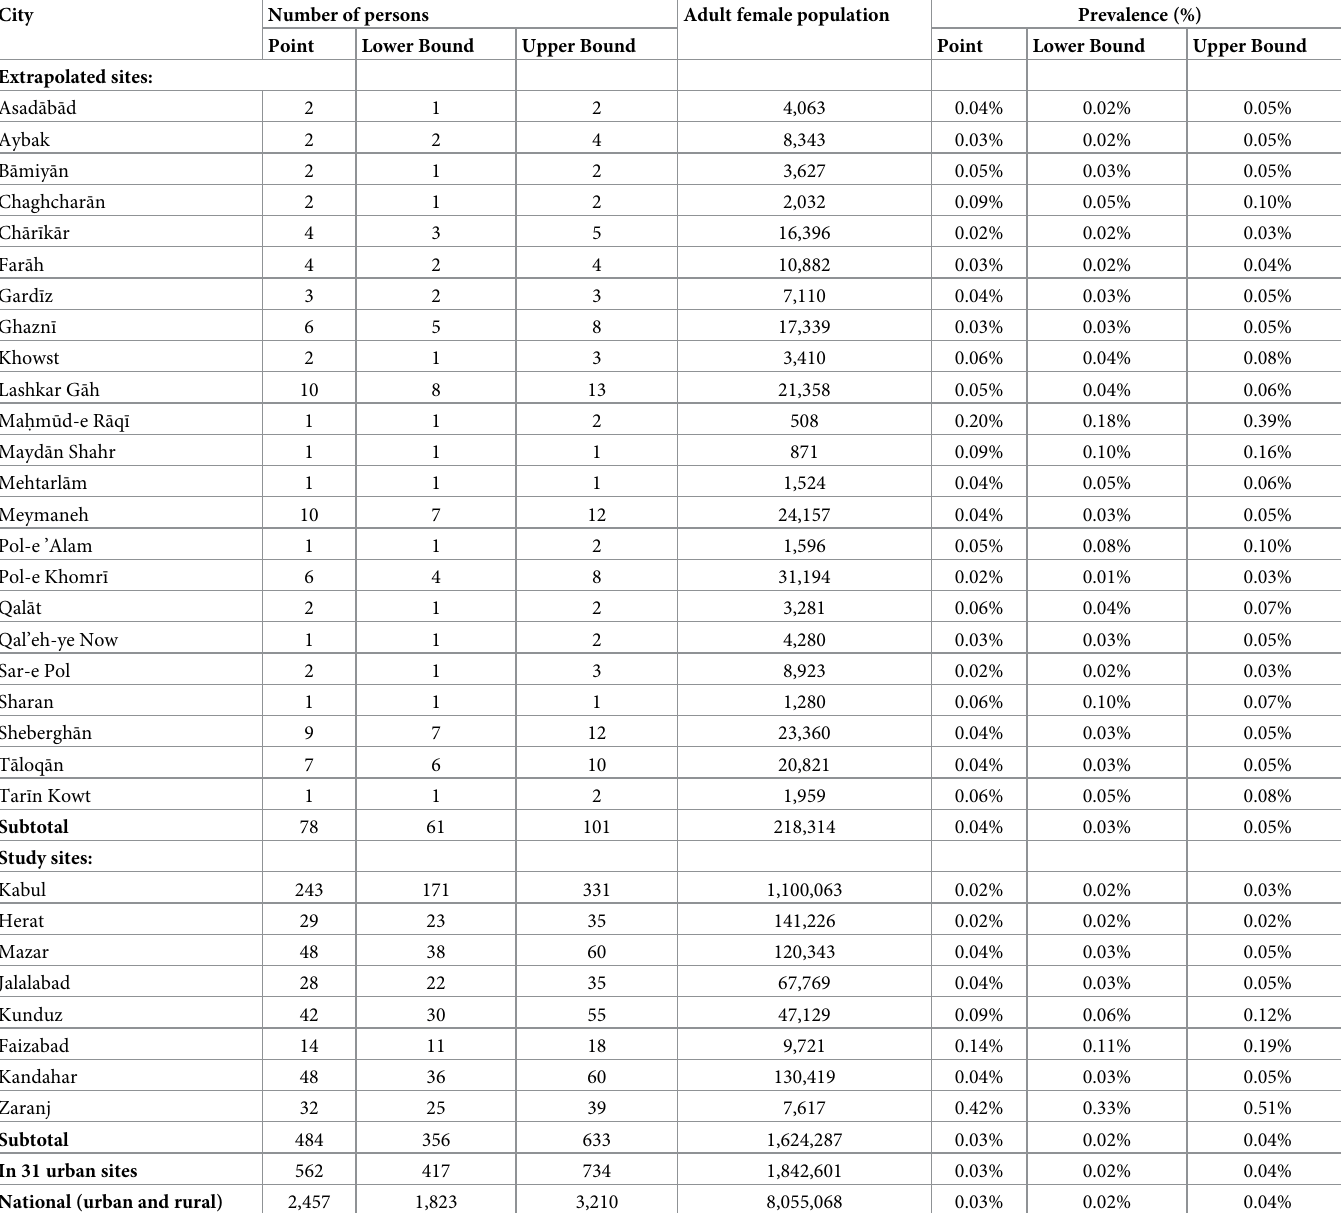
Table 9. Extrapolated population size and prevalence estimates for female people who inject drugs (PWID) in the adult female population (15–64 years old) in major cities in Afghanistan, and at the national level in 2019 (adjusted for winter seasonality effect).